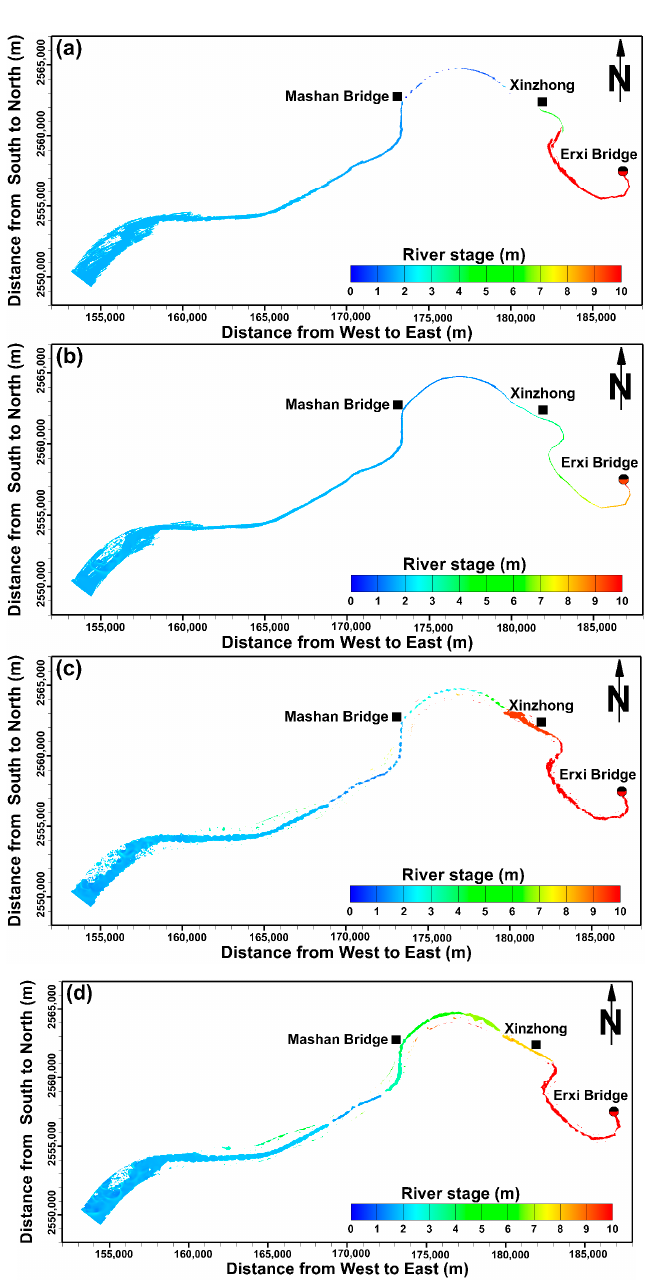
Figure 8. A comparison of the simulated and observed river stages at the Xinzhong station under low flow conditions using the 2D model with the: ( a ) original cross-section data; and resampled cross-section data according to: ( b ) the linear interpolation method; ( c ) the IDW method, and ( d ) the NN method.